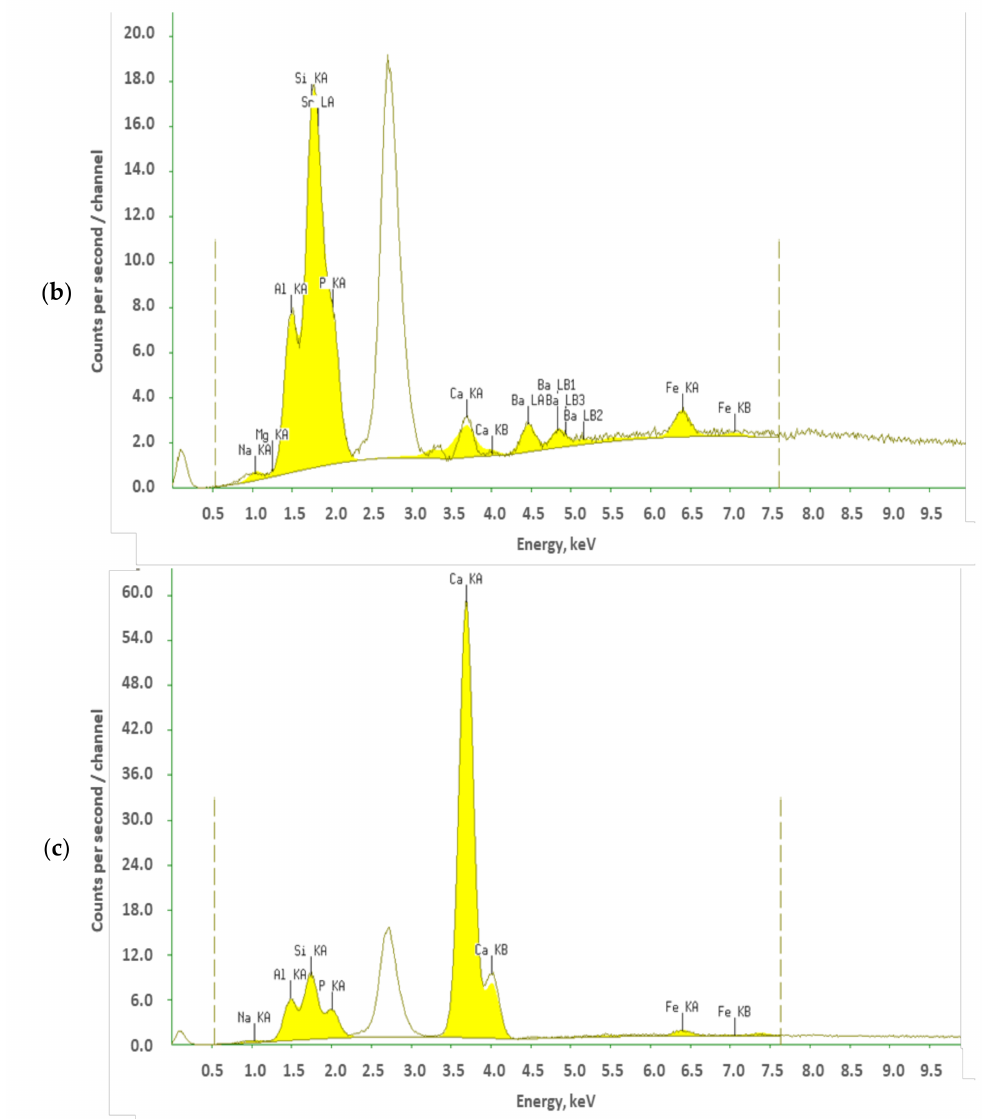
Figure 2. XRF spectrum (13 kV) of ( a ) Fuji IX glass; ( b ) Kavitan Plus glass; ( c ) Chemadent G-J-W